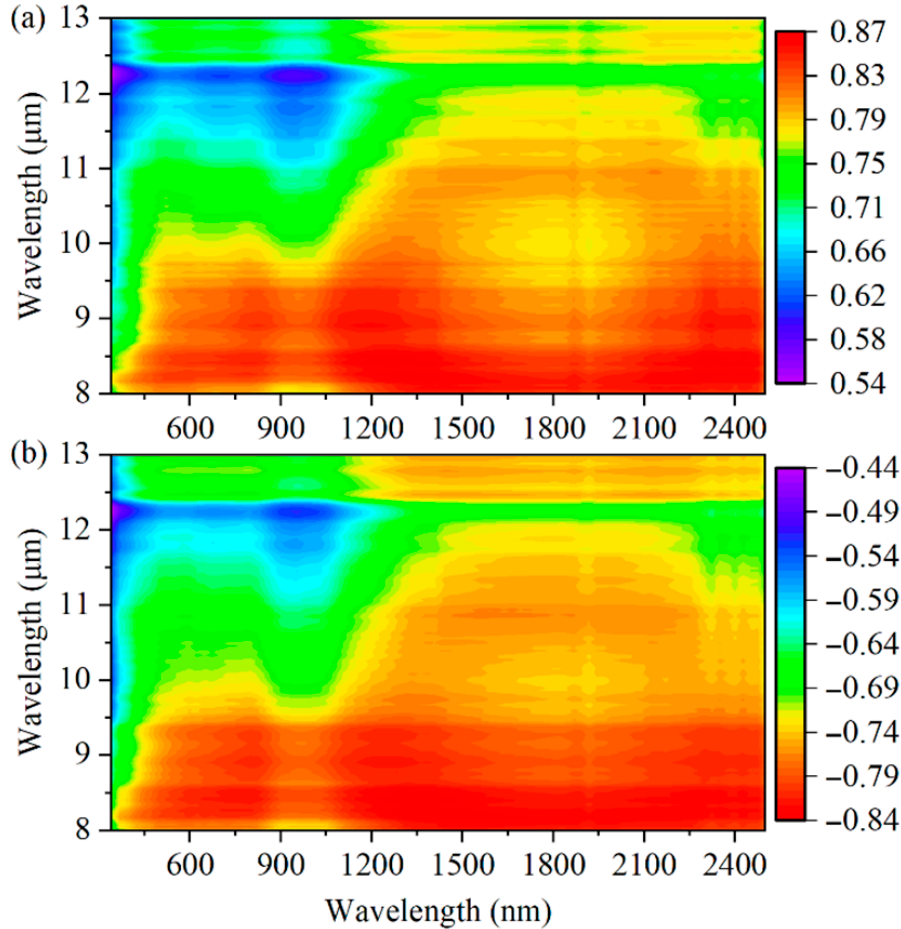
Figure 8. Correlation of OPA-fused absorbance data back-transformed into a matrix with TFe ( a ) and SiO 2 ( b ). X -axis represents the wavelengths of VIS–NIR spectra. Y -axis represents the wavelengths of TIR spectra. The absolute values of correlation coefficients decrease from red to blue in the color bar.